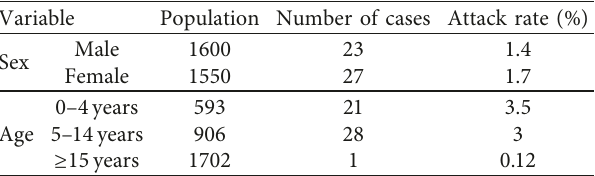
Table 1: Sex- and age-specific attack rate of rubella cases in Amuma Wuchale Kebele, Kuyu District, North Shewa Zone, Oromia Re- gion,